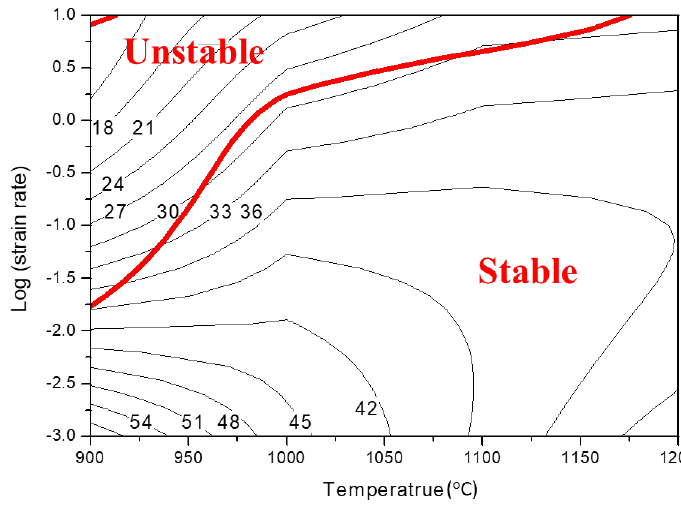
Figure 5. Processing map of the UF-TiB/Ti-6Al-4V composite prepared by P/M method ( ε = 0.6)